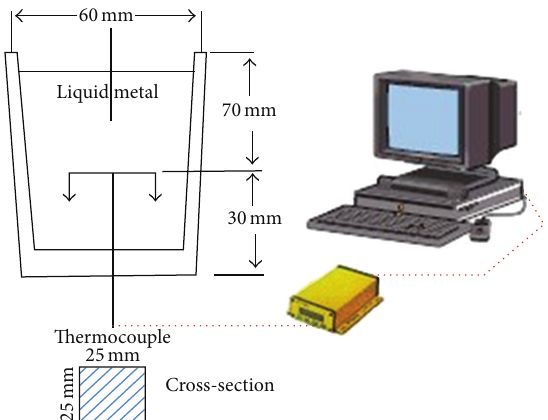
Figure 1: Graphite mold and data acquisition system used in the present study.